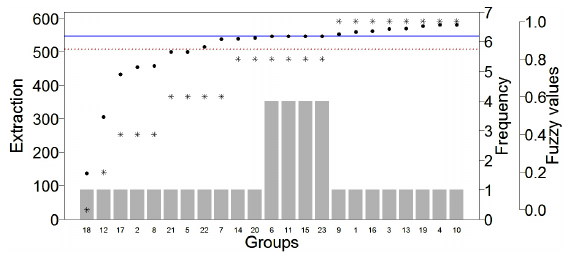
Fig. 3 . Selection of successful (above the median of extractions) and unsuccessful (below the median of extractions) groups and fuzzy values to run qualitative comparative analysis. The amount of water extracted, the number of group that extracted each amount, and the fuzzy values assigned are represented for each group. Circular dots represent groups’ resource extraction levels, stars represent fuzzy values, and bars mark the frequency of groups extracting at the same level as the given group (e.g., groups 6,11,15, and 23 extracted the same amount of water; thus, the frequency is 4. For all other groups, their extraction level is unique (i.e., their frequency is 1), numbers represent group number, the blue line represents the median of extractions, and the dotted red line represents average extractions